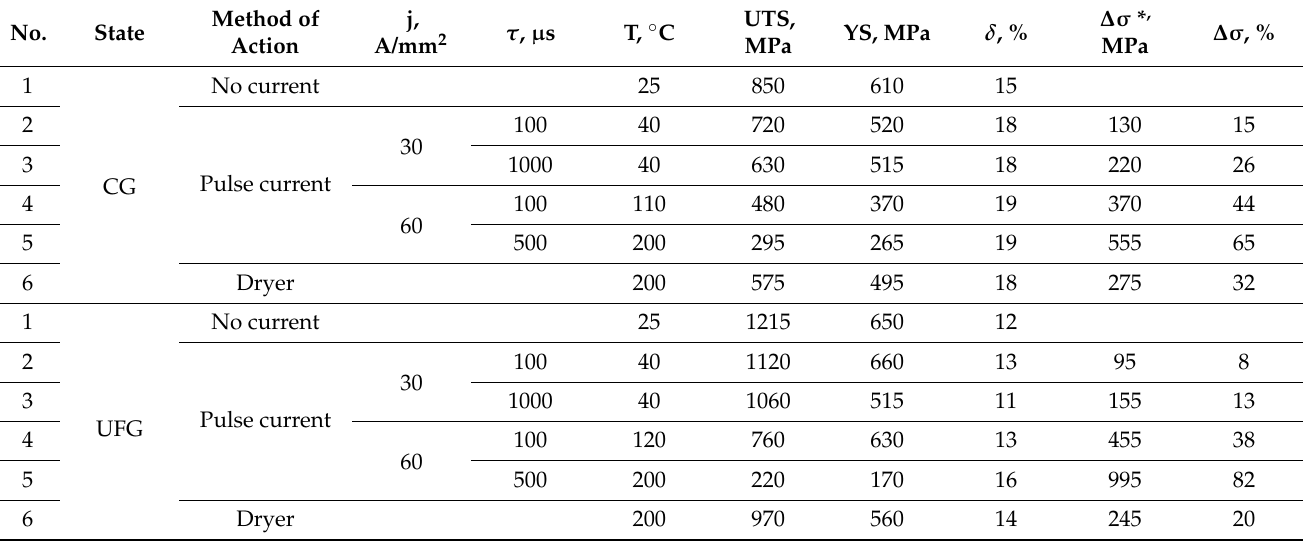
Table 4. Mechanical properties of CG and UFG